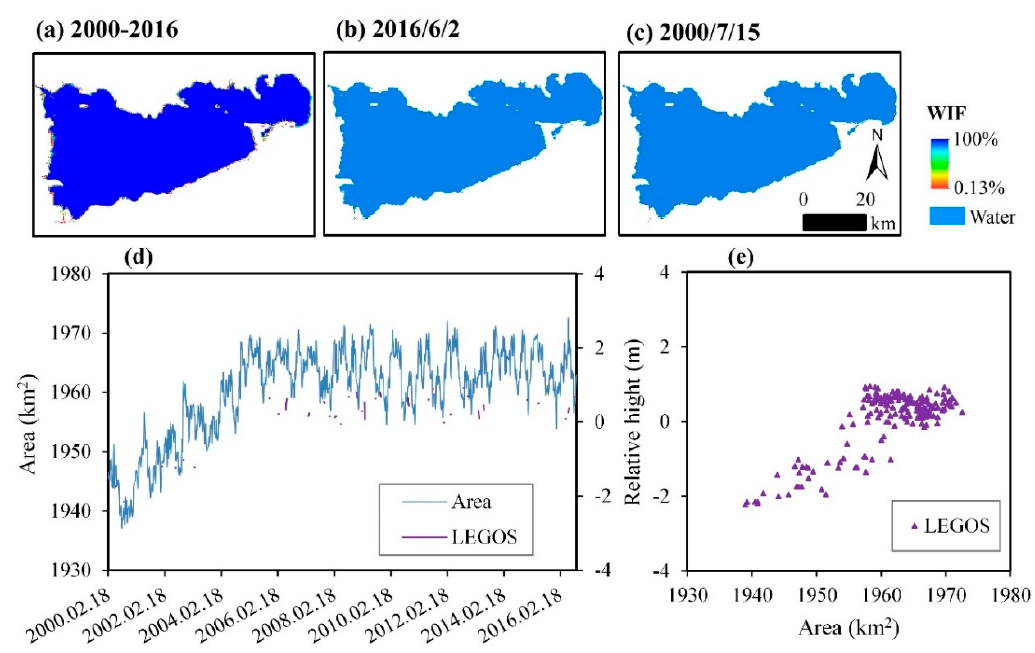
Figure 10. Spatial distribution and temporal variation of Namco Lake. ( a ) The WIF map in 2000–2016; ( b ) water body map of 2016 / 6 / 2, with the largest water area in 2000–2016; ( c ) water body map of 2000 / 7 / 15, with the smallest water area in 2000–2016; ( d ) time series of the water area (km 2 ) and relative height (m) in 2000–2016; and ( e ) correlation between water area (km 2 ) and relative height (m).